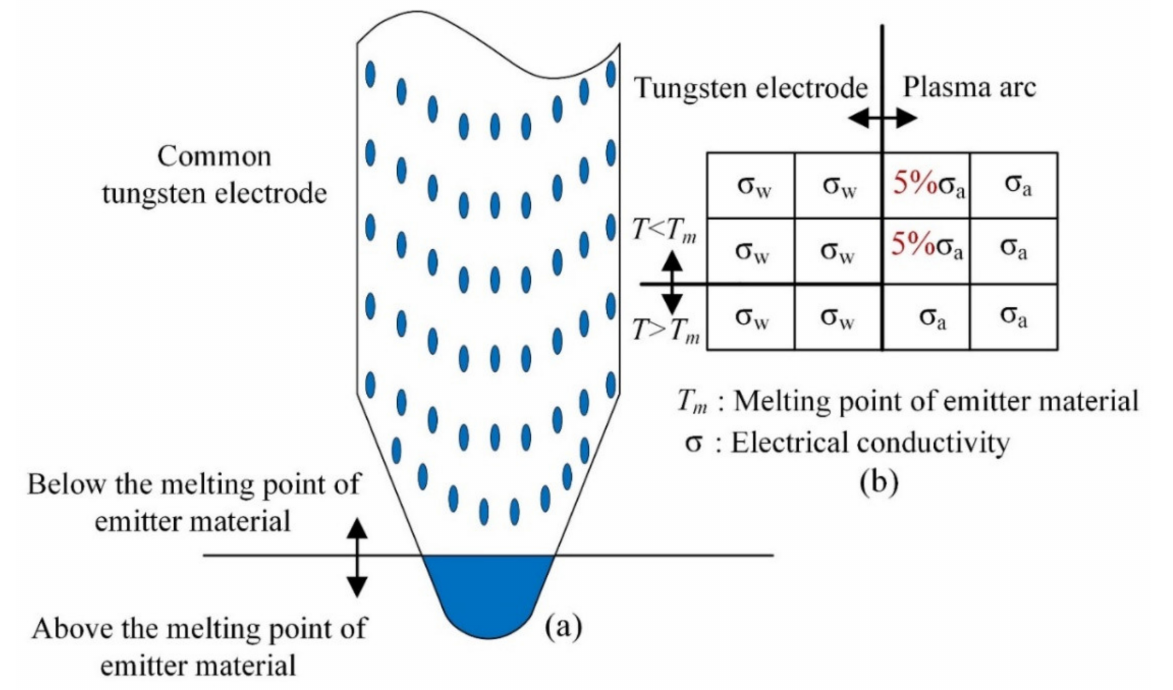
Figure 4. ( a ) Schematic diagram of the current attachment on the tungsten electrode, ( b ) treatment of current attachment.